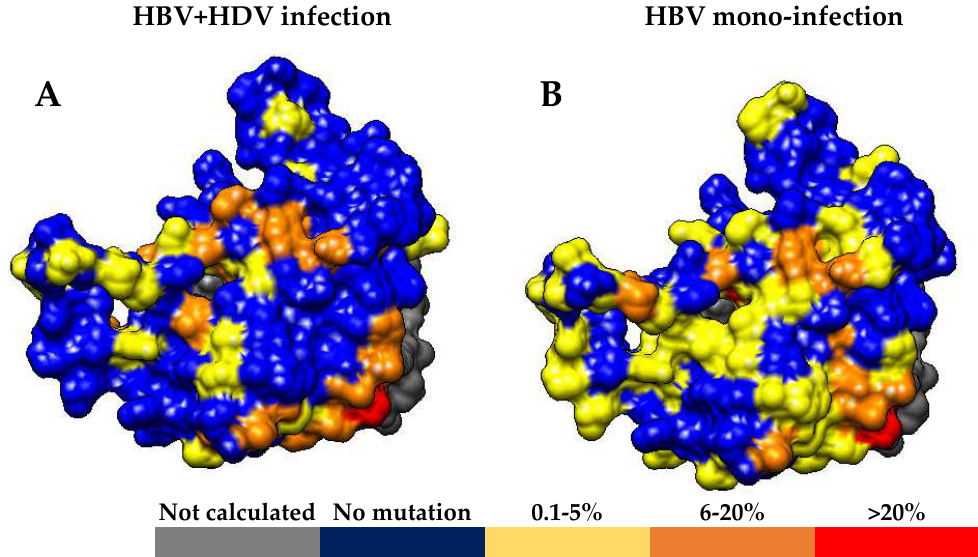
Figure 2. Three-dimensional structure of HBV genotype D HBsAg. HBsAg structure was built by using I-TASSER [24], and colored by using UCSF Chimera [23]. In patients with chronic HBV + HDV infection ( A ) and HBV mono-infection ( B ), residues were colored according to the percentage of mutations detected: 0% Blue, 0.1–5% Yellow, 6–20% Orange and >20% Red.